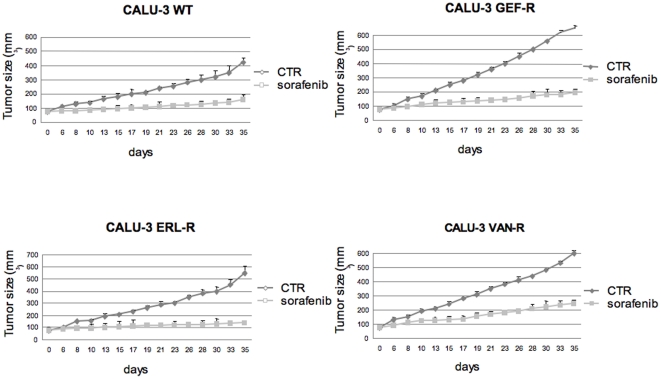
Antitumor activity of the sorafenib in parental and TKI-resistant CALU-3 xenografts.A, Parental (WT) CALU-3 cancer cells; B, GEF-R CALU-3 cancer cells; C, VAN-R CALU-3cancer cells; D, ERL-R CALU-3 cancer cells. Athymic nude mice were injected subcutaneously into the dorsal flank with 107 cancer cells. After 7 to 10 days (average tumor size, 75 mm3), mice were treated as indicated in Materials and Methods for 5 weeks. Each treatment group consisted of 8 mice. Data represent the average (±SD). Student's t test was used to compare tumor sizes among different treatment groups at day 35 following the start of treatment. A, CALU-3 WT: sorafenib versus control (two-sided p<0.001); B, CALU-3 GEF-R: sorafenib versus control (two-sided p<0.001). C, CALU-3 VAN-R: sorafenib versus control (two-sided p<0.001); D, CALU-3 ERL-R: sorafenib versus control (two-sided p<0.001).